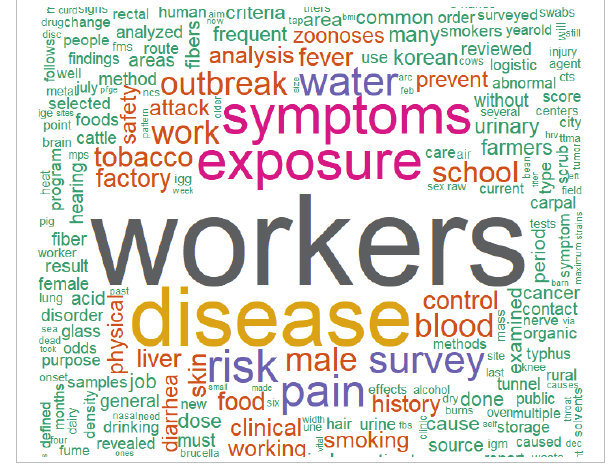
Figure 3. Word cloud presentation of Dr. Hyun-Sul Lim’s published articles based on their